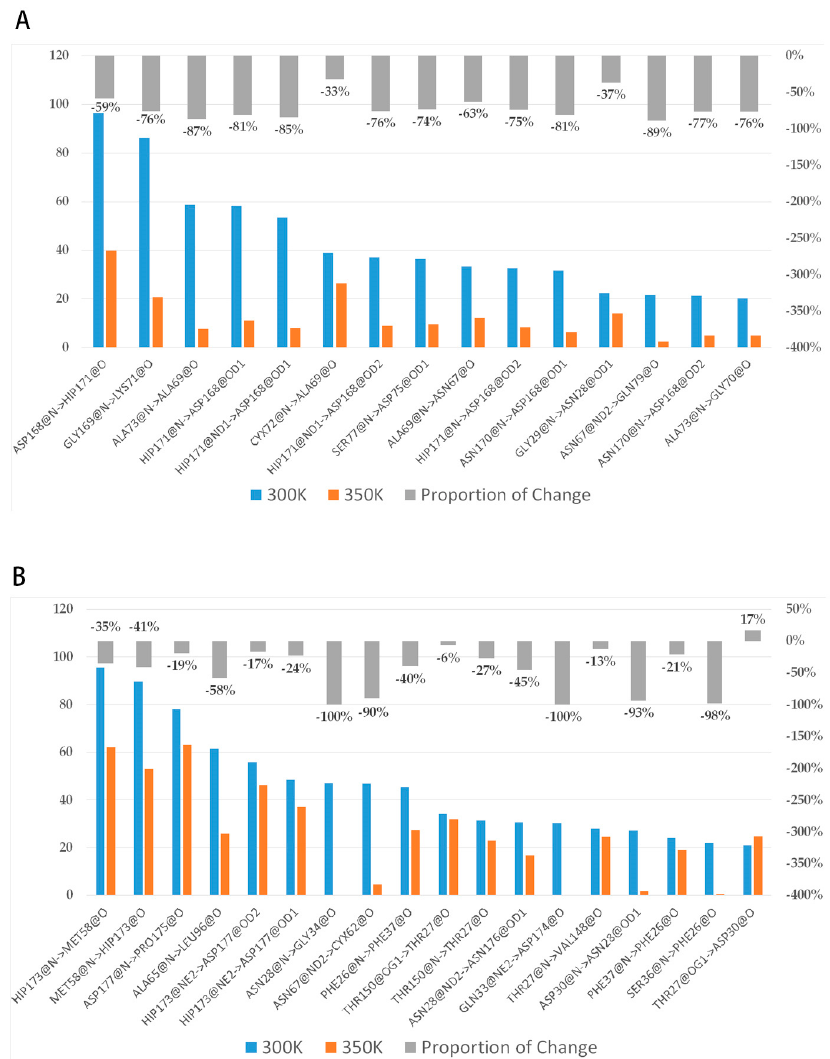
Figure 10. ( A , B ) show the change in probability of intra-group and inter-group H-bonds, respec- tively. The blue-orange bar charts represent the proportion of important hydrogen bonds that occur, and the gray bar charts represent the percentages of changes in the proportions relative to themselves after heating up.